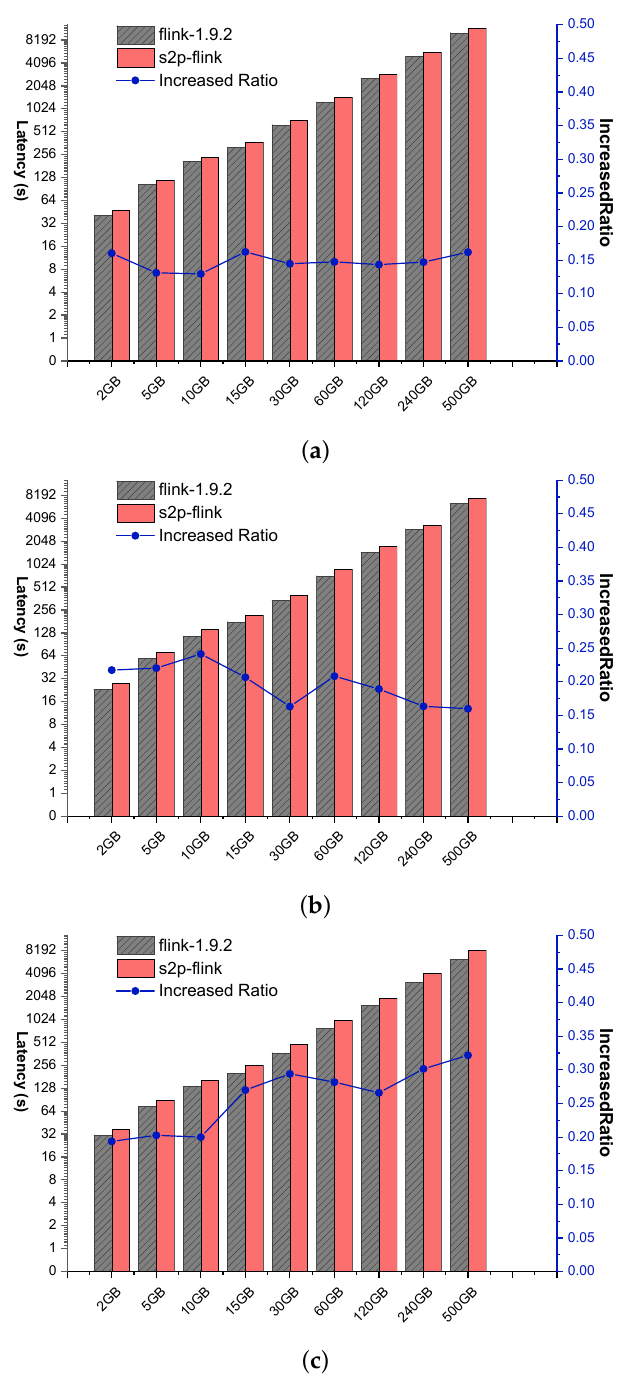
Figure 11. ( a ) P1 cost results; ( b ) P2 cost results; ( c ) P3 cost